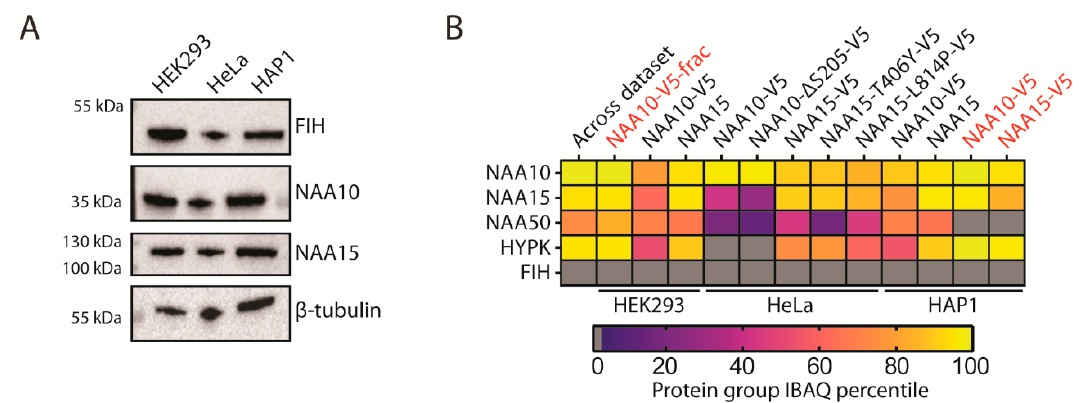
Figure 2. NAA10 does not interact with FIH. ( A ) Immunoblots of HEK293, HeLa, and HAP1 cells with the indicated antibodies. ( B ) Percentile score of iBAQ values for the known NatA complex subunits and FIH in each sample. Red text: samples prepared by in-solution digestion. Black text: samples prepared by FASP.